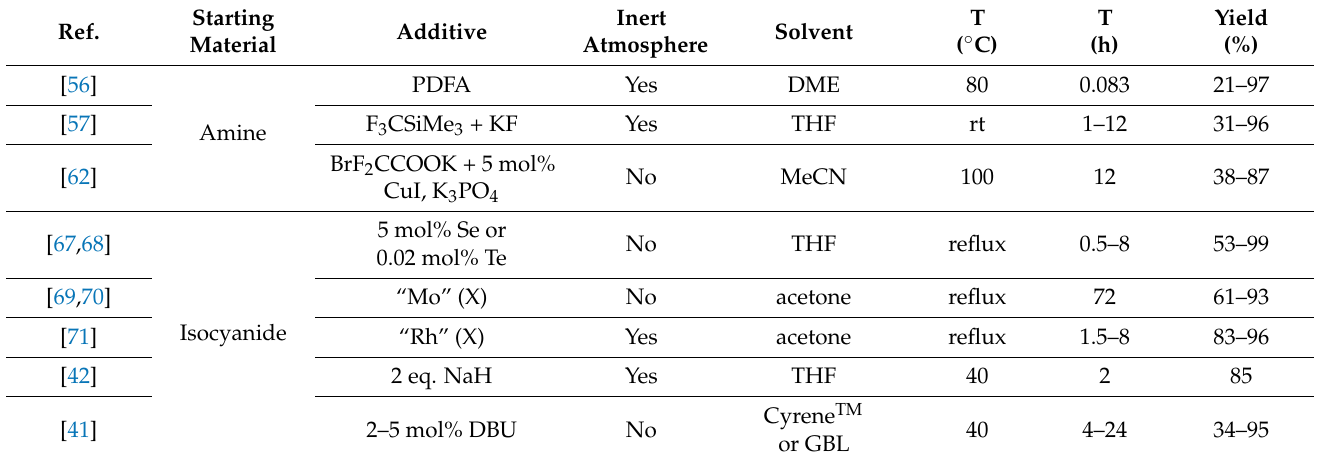
Table 1. Summary of methods for ITC synthesis with the application of elemental sulfur.